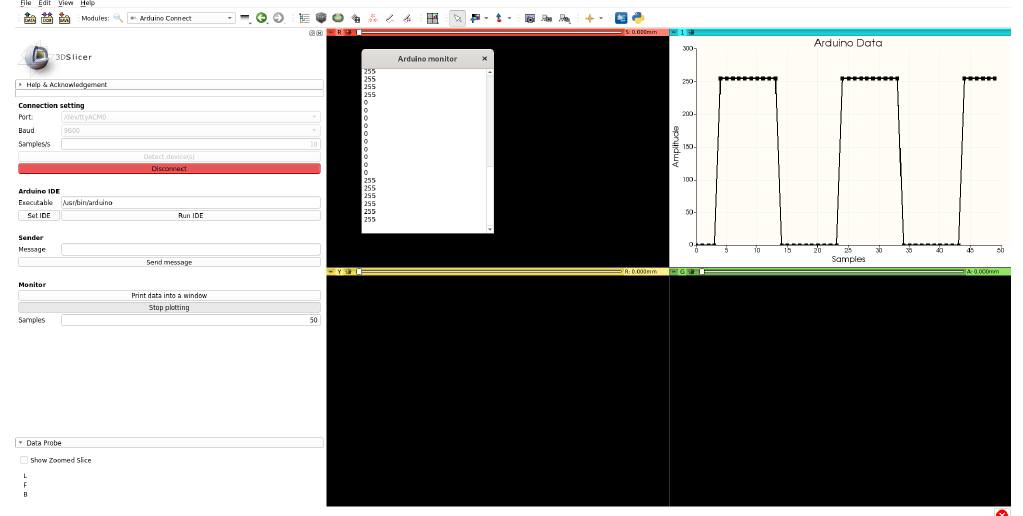
Figure 2. Data stream visualization coming from an established hardware